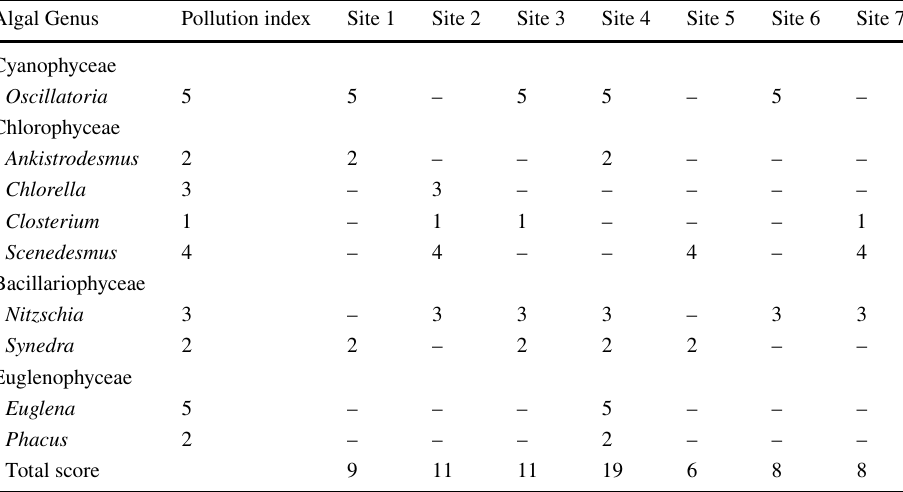
Table 6 Pollution index of algal genera according to Palmer (1969) at seven study